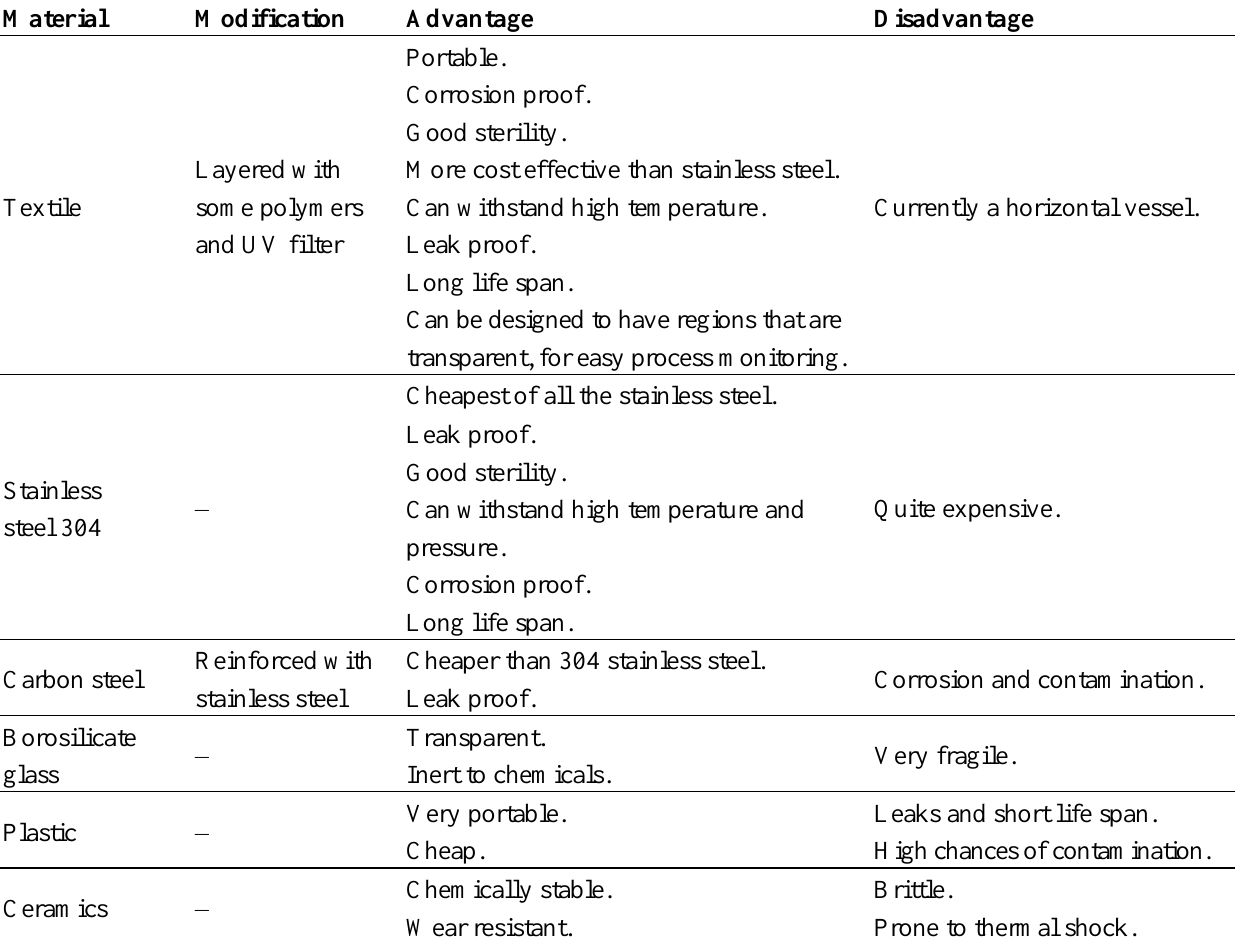
Table 2. Advantages and disadvantages of possible materials for construction for ethanol bioreactors